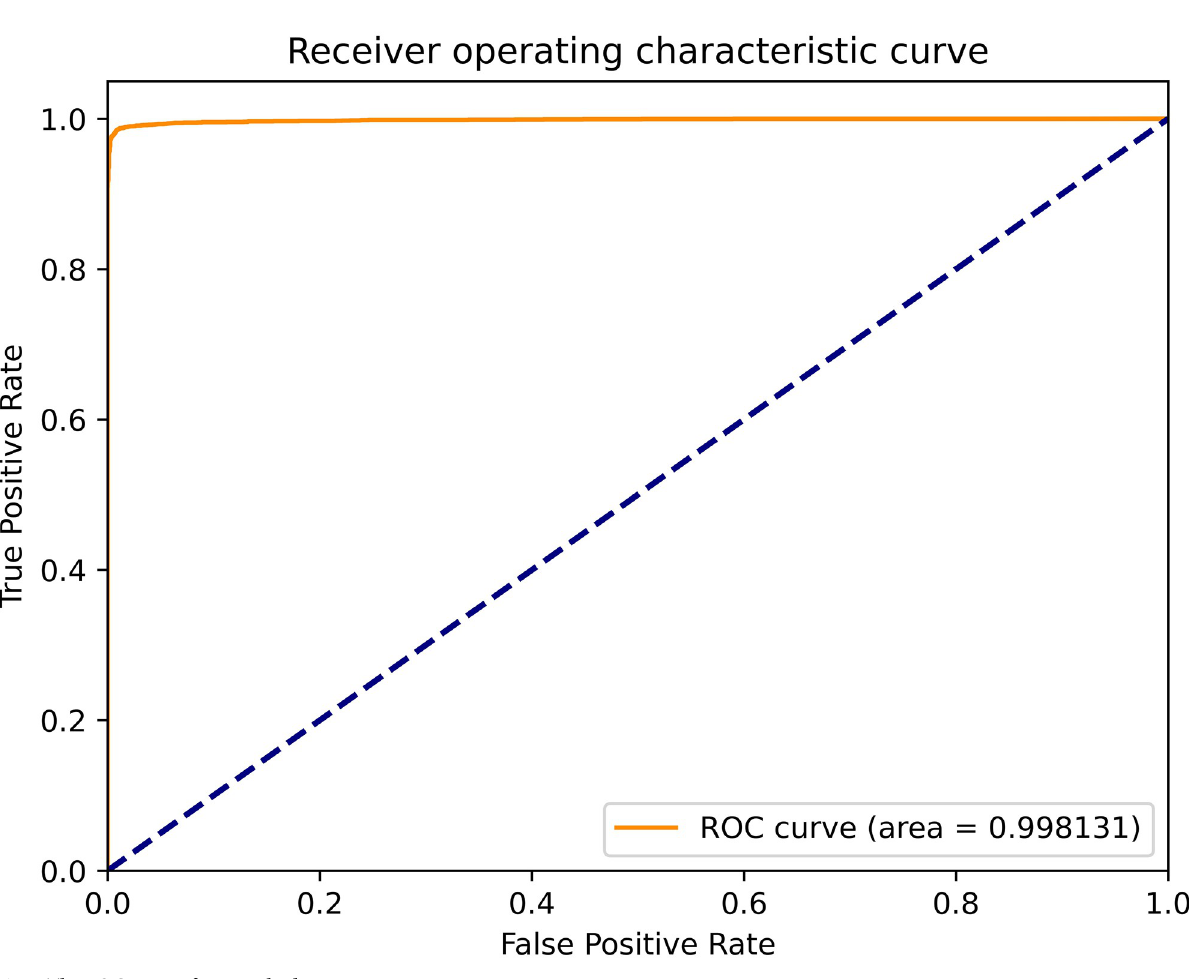
Fig 7. The ROC curve of our method.